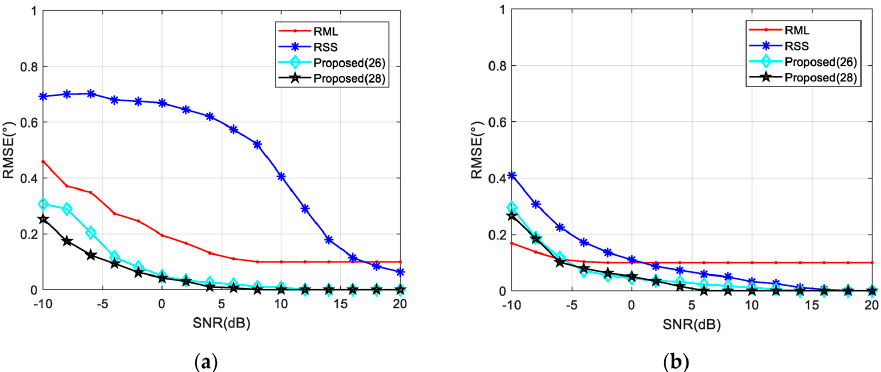
Figure 9. RMSE against input SNR in di ff erent elevation angles when ρ = 0.7. ( a ) θ = 1 ◦ and ( b ) θ = 5 ◦